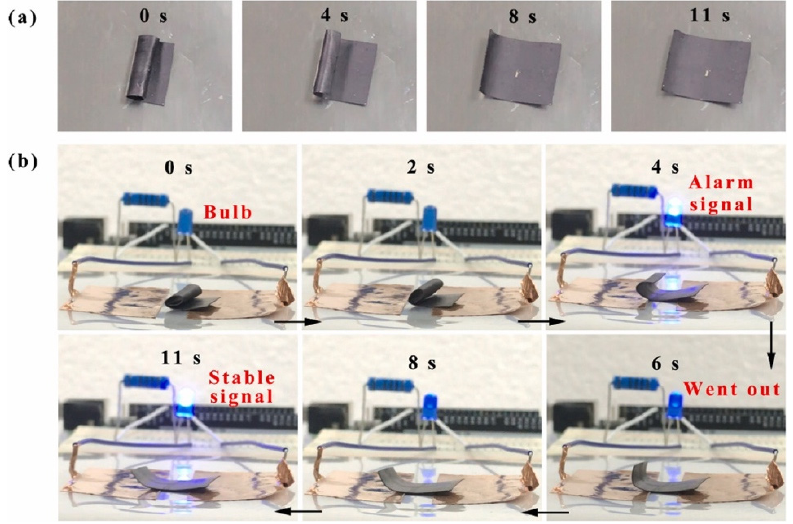
Figure 18. ( a ) Shape recovery of rolled-up paper. ( b ) Shape-memory behavior of the SMPU/MXene and its potential use as a fire alarm sensor [229].